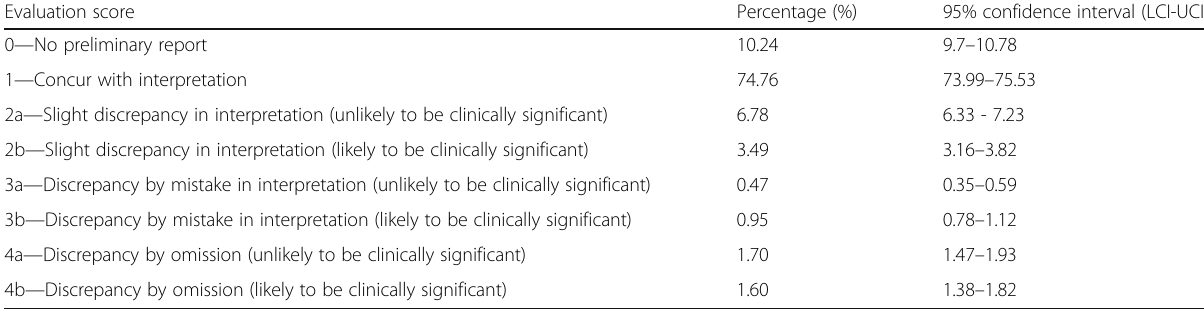
LCI lower confidence interval, UCI upper confidence